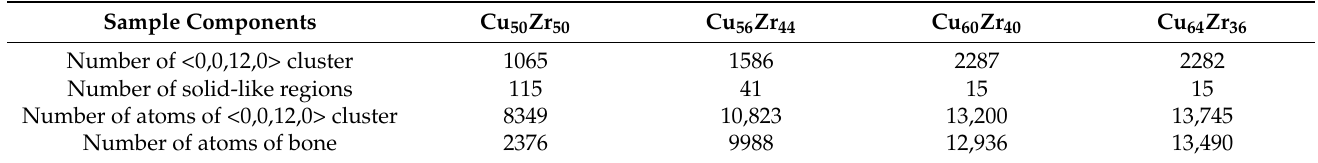
Table 1. Cu X Zr 100 − X (X = 50, 56, 60, 64) MGs full icosahedral bones parameters